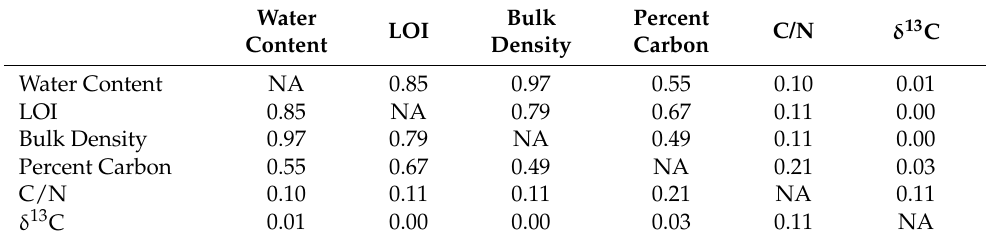
Table 2. Correlation matrix ( r 2 values) for all of the measured surface sample variables (mangrove and salt marsh combined) including water content, loss on ignition (LOI), bulk density, percent carbon, and δ 13